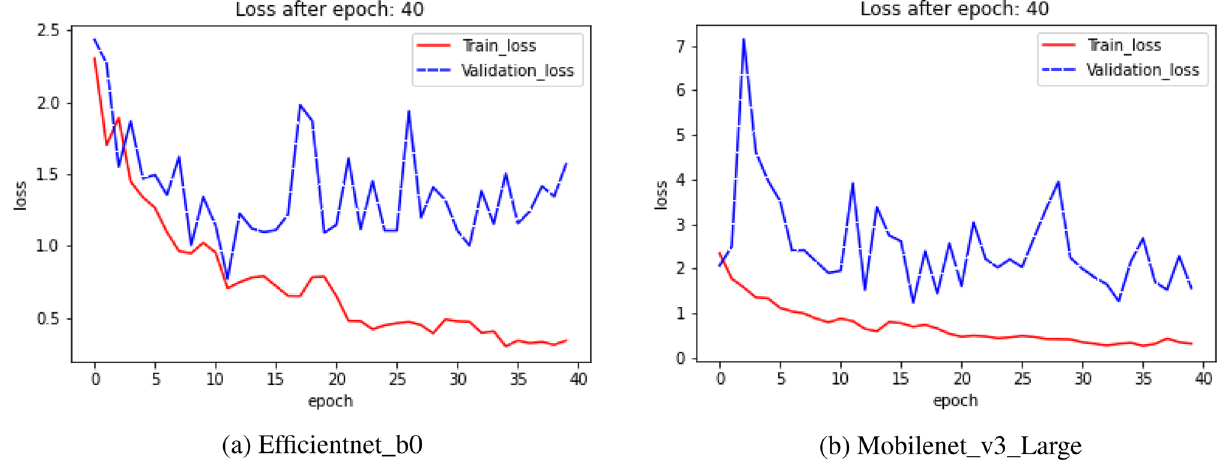
Figure 12. Graph showing the Loss plot generated by ( a ) Efficientnet_b0 and ( b ) Mobilenet_v3_Large transfer learning models on HARTH dataset.